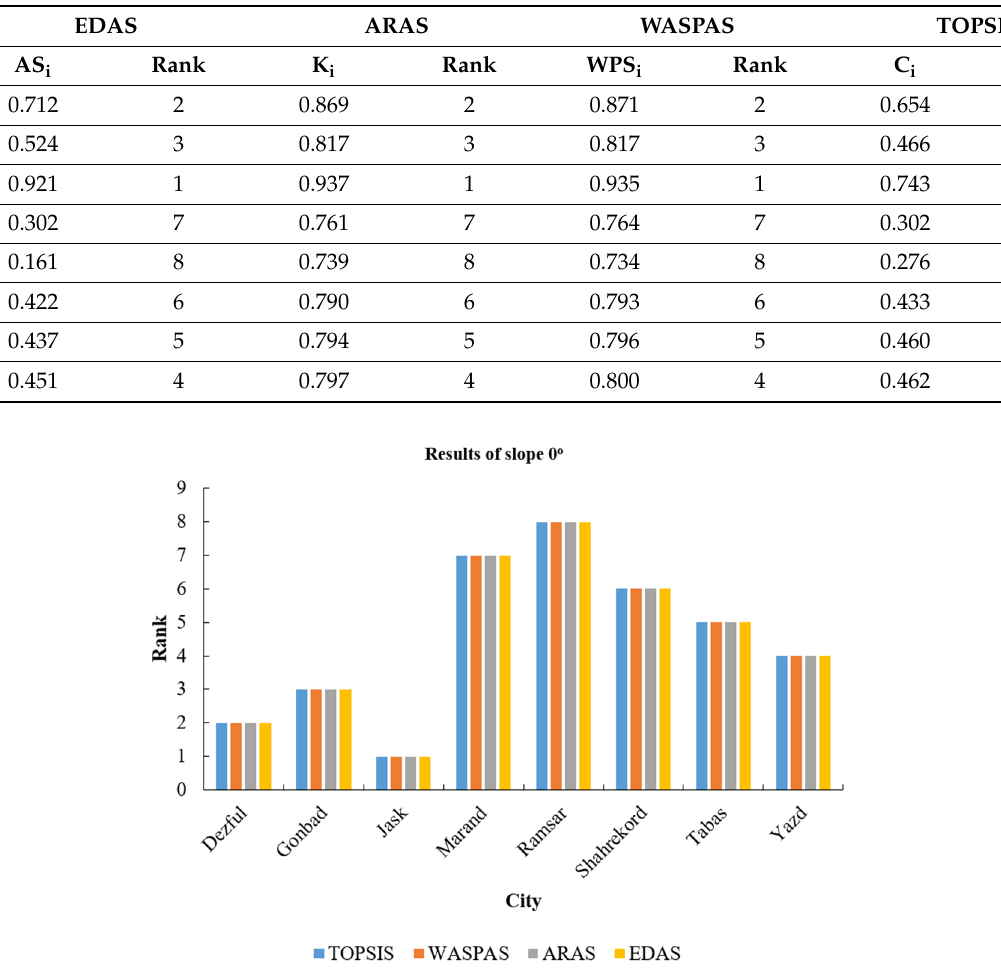
Figure 11. Comparing the ranking of cities on a 0° slope.